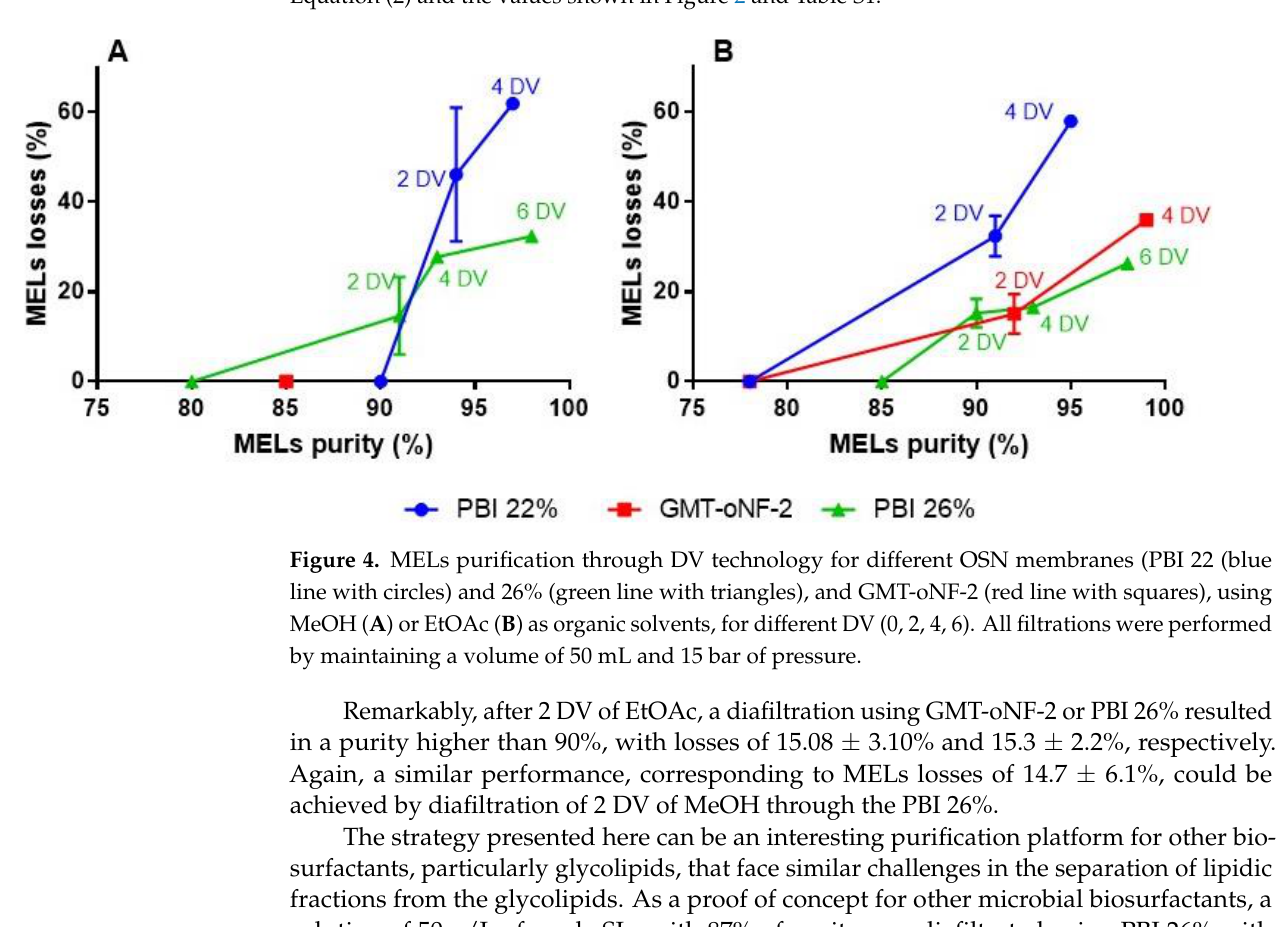
Figure 3. Theoretical minimum DV vs. calculated MELs losses for each OSN membrane: PBI 22, 24 and 26%; GMT-oNF-2 and DuraMem-500, for MeOH (grey circles) and EtOAc (black squares) as organic solvents, to achieve at least 97% of MELs purity. All these results were calculated using Equation (2) and the values shown in Figure 2 and Table S1.